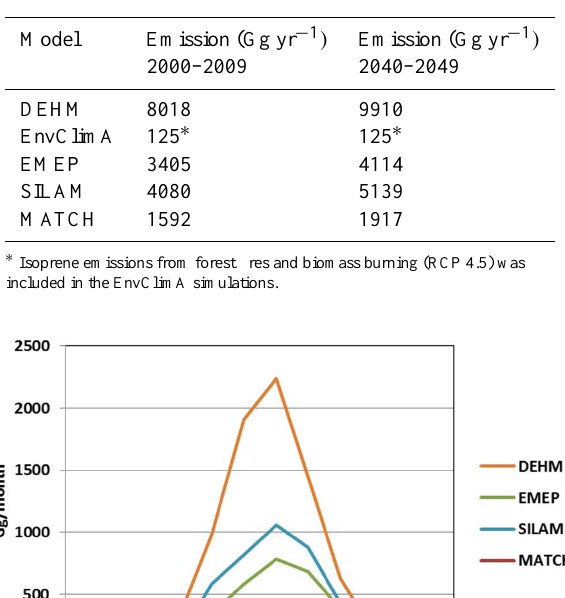
Table 1. Annual biogenic emissions of isoprene in models.